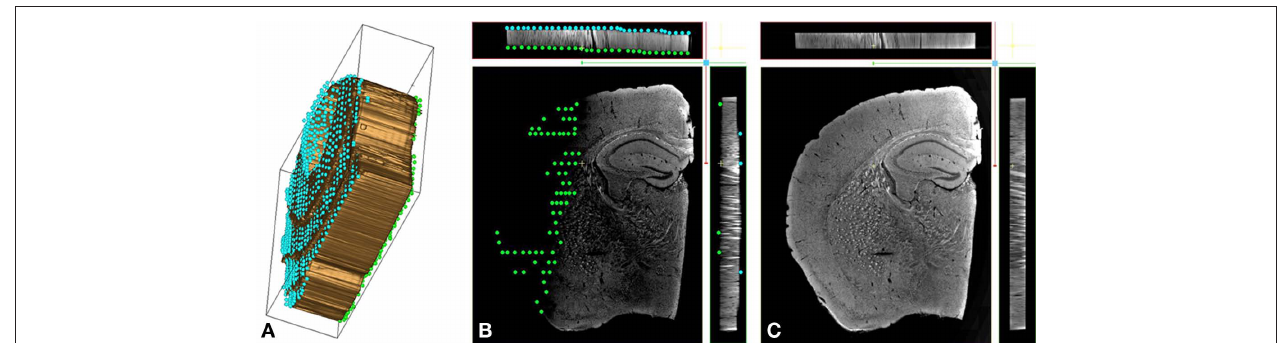
boundaries. These points are used as references during the flattening procedure. The specimen aspect ratio was modified and stretched along the z direction to allow the manual positioning of the marker points in the viewer. (C) XYZ view of a flattened mouse brain coronal section within the IMOD viewer. A warped section is submitted to local compressions/expansions along z the direction, forcing the specimen boundaries onto two parallel planes. The transformation leaves the section volume unchanged.